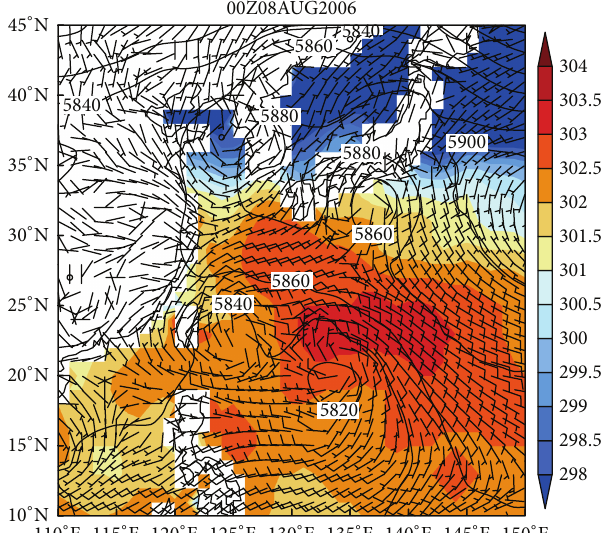
Figure 1: Geopotential height at 500hPa (contour, 20-meter inter- val), SST (shaded), and wind (vector) at 10-meter wind from the 1 ∘ ×1 ∘ NCEP FNL operational global analysis at 0000 UTC 8 August, 2006.